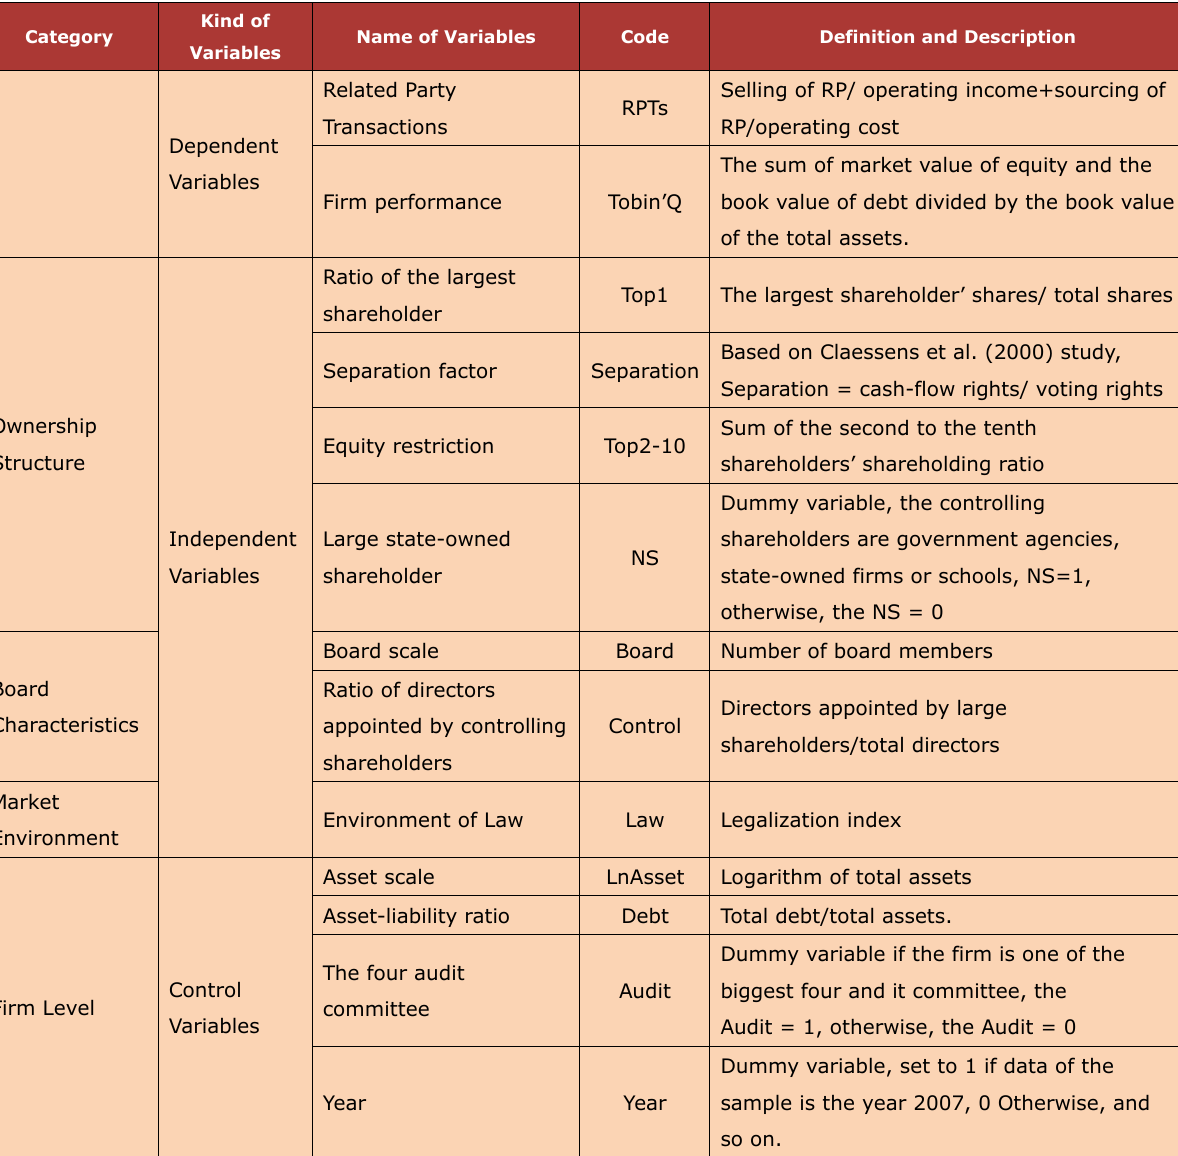
Table 1. Variables Defined and Descriptive